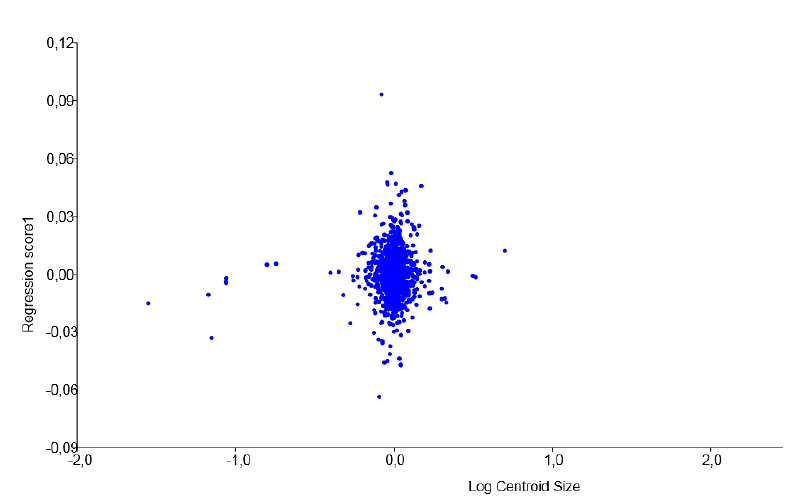
Figure 4. Regression asymmetry component (asymmetry matrix pooled by leaf) from centroid size